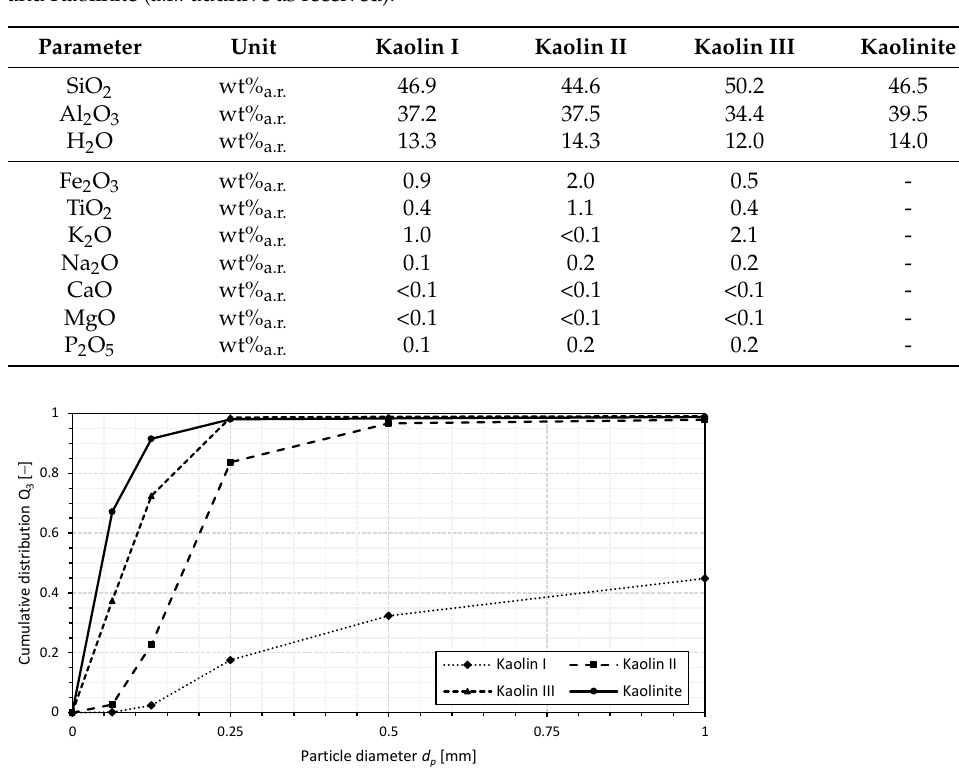
Figure 1. Cumulative particle size distributions of the aluminum-silicate-based additives Kaolin I, Kaolin II, Kaolin III, and Kaolinite (Q 3 : cumulative distribution of the quantity type “mass” determined by sieve analysis) .